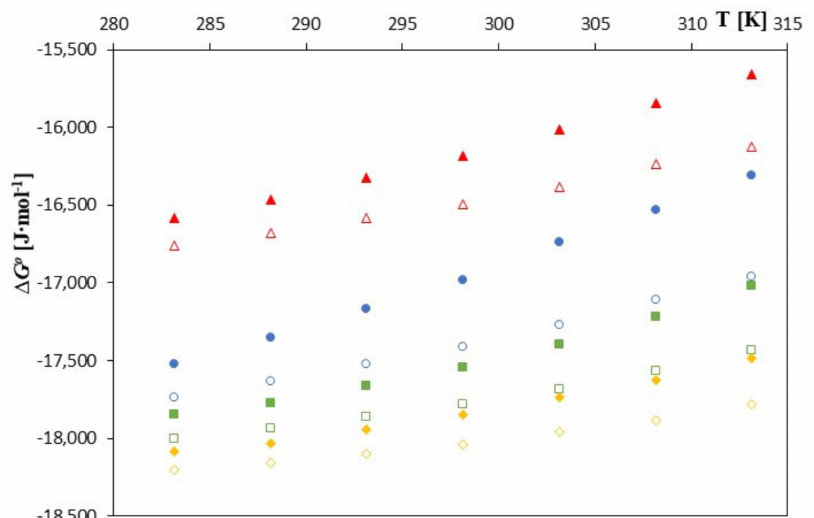
Figure 3. The plots of dependence ∆ G 0 [J · mol − 1 ] in the function T [K] for β -cyclodextrin with all studied salts.: - trans -cinnamic acid; - trans –p-coumaric acid; - trans -caffeic acid; - trans -ferulic acid and 2-HP- β -cyclodextrin with the studied salts.: - trans -cinnamic acid; - trans –p-coumaric acid; - trans -caffeic acid; - trans -ferulic acid.